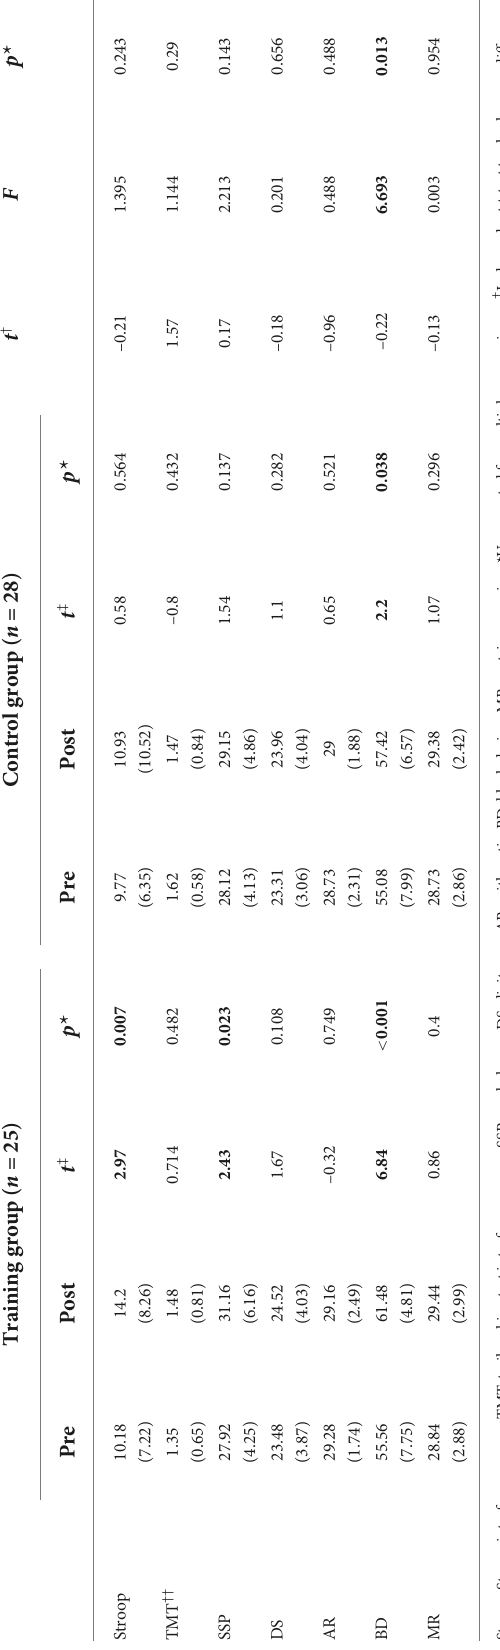
Figure 4 , left]. Follow-up paired t -tests showed that the CON degree significantly increased in the training group [ t (24) = – 2.01, p = 0.028, r = 0.38, one-tailed], whereas no change was observed in the control group. Density-averaged degree in